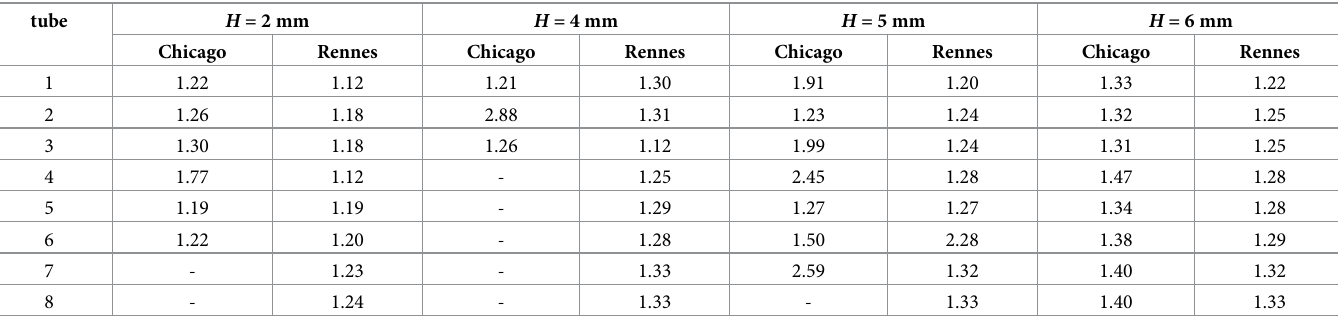
are fitting parameters. The fitting results of overall packing densities are similarly satisfactory Table 1. The local packing density estimations of the steady-state.